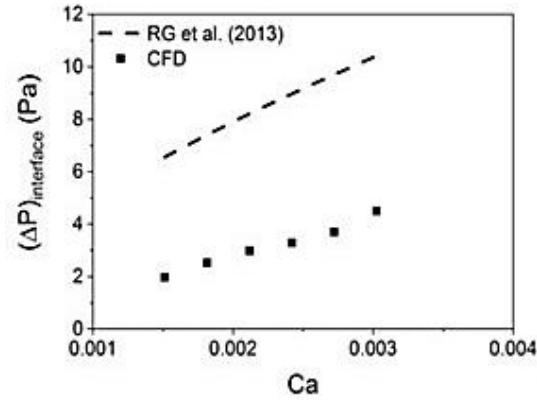
Figure 10. Comparison of the interfacial pressure drop as a function of Capillary number between the present CFD results and that obtained from Eq. (7) for Pd5-water